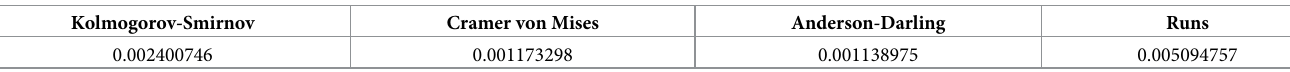
Table 1. Complete series uniformity tests p-values.